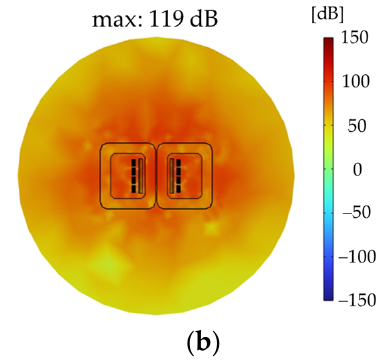
Figure 16. Sound pressure level distribution diagram under middle-winding short circuit ( a ) Inter- leaved winding; ( b ) Continuous winding.